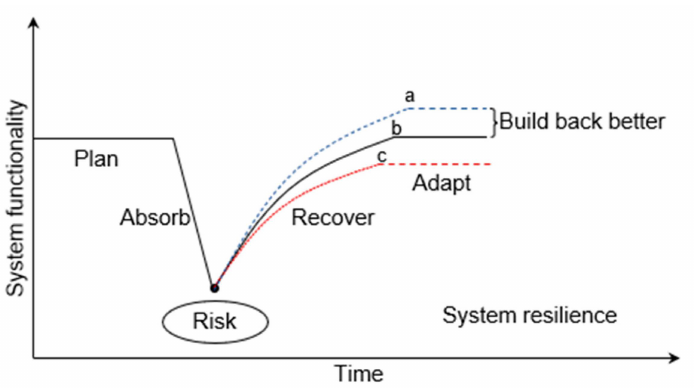
Figure 4. Resilience management framework centered on disaster risk analysis. (a. The post-disaster state is better than the pre-disaster state; b. The post-disaster state is equal to the pre-disaster state; c. The post-disaster state is weaker than the pre-disaster